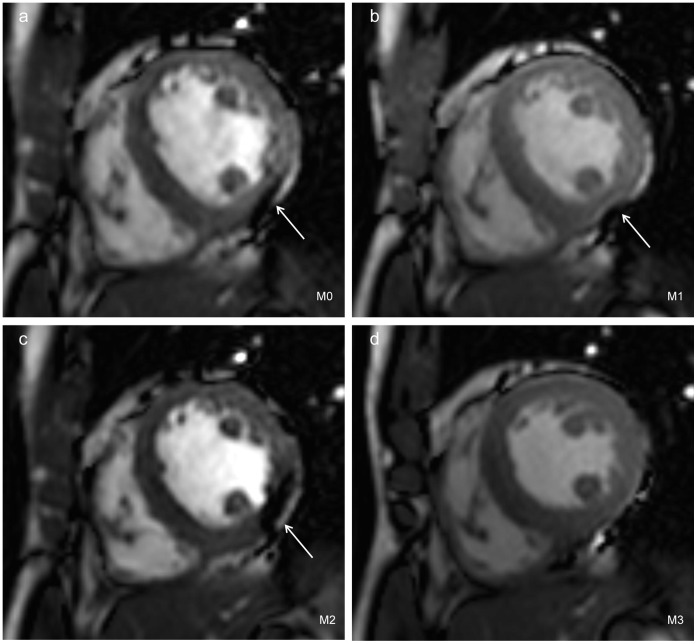
Artifacts on the short-axis B-TFE images of four groups.The cine images acquired in groups M0 (a), M1 (b) and M2 (c) were all suffered from dark banding artifacts (thin arrows) seriously. Compared with group M0 (a), group M1 (b) reduced the dark banding artifacts to some extent and was better on the image homogeneity. Within the four groups, the CR of group M2 (c) was largest when the FA was increased, however, the off-resonance artifacts of group M2 (c) was pronounced in the ventricular wall (thin arrows). The off-resonance artifacts (thin arrows) of group M3 (d) were reduced and shifted away from the heart with dual-source RF shimming and a shortest TR, furthermore, group M3 (d) achieved good CR of blood-to myocardium contrast.